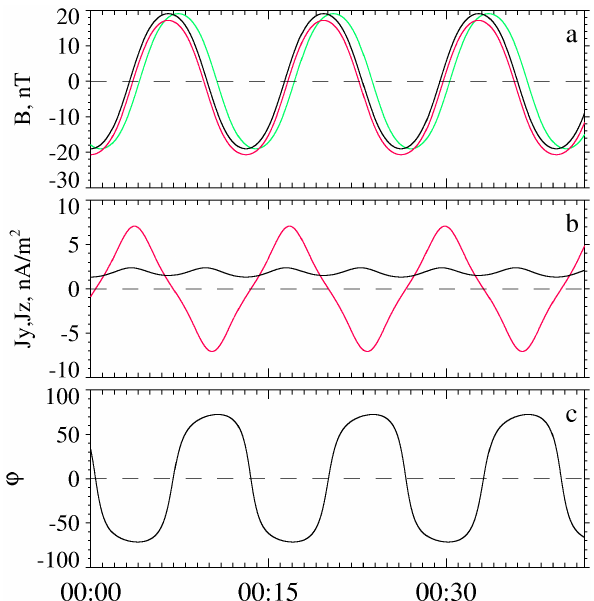
Fig. 4. Model current sheet with one monochromatic wave. (a) Magnetic field B x . Colors denote three virtual satellites (see text for positions). (b) J y (black) and J z (red) current density. (c) φ , tilt of the normal in the Y-Z plane. The time axis is in hh:mm format (arbitrary time).